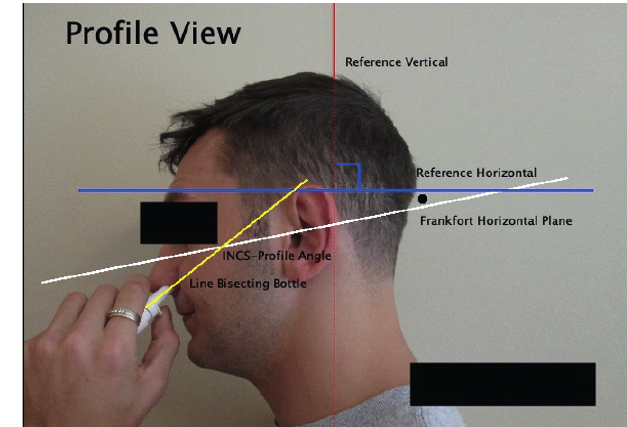
Figure 3. Photo documentation of the profile view of a patient using spray bottle in the left naris. Profile pictures were obtained on a wall with a vertical reference line (red). A line bisecting bottle was drawn (yel- low line). Frankfort horizontal plane is drawn from the highest point of the opening of the external auditory canal through the lower margin of the orbit (white line). The INCS-Profile Angle was then calculated at the intersection of the line bisecting the bottle and the Frankfort horizontal plane. The Head Profile Tilt was calculated at the intersection of the ref- erence horizontal line and the Frankfort horizontal plane, where the • is located.